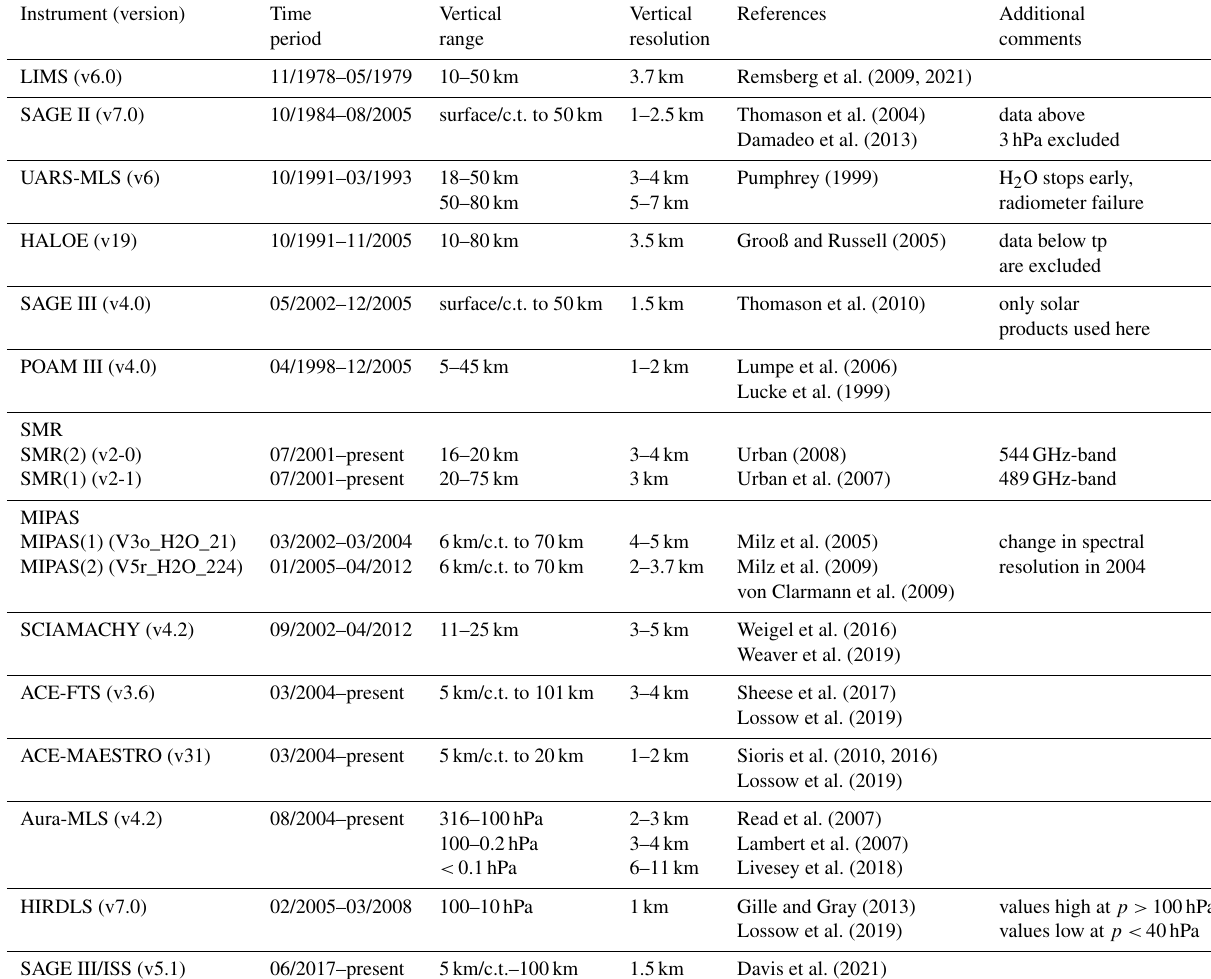
Table 10. Time period, vertical range, vertical resolution, references, and other comments for H 2 O measurements. Note that tp refers to tropopause, p to pressure, and c.t. to cloud top in this